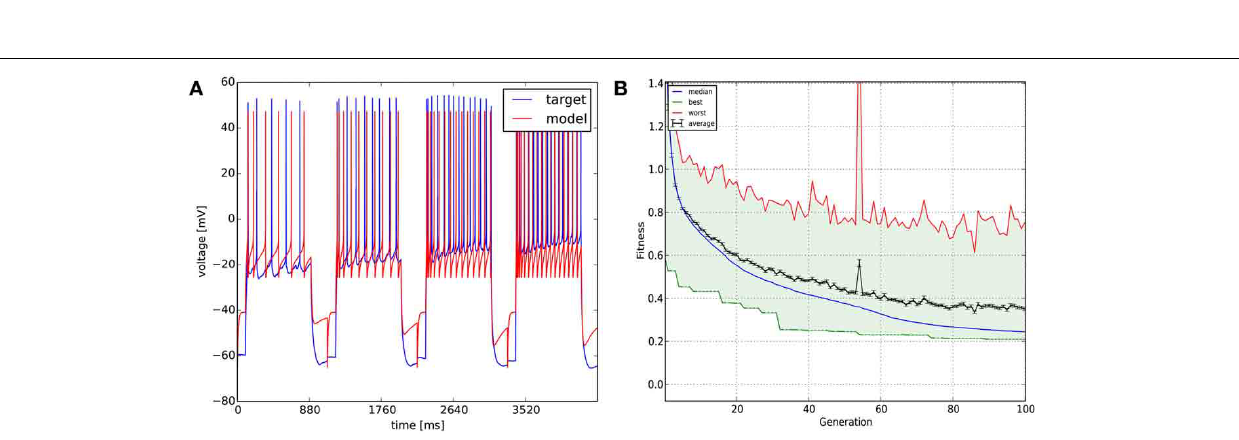
FIGURE 7 | The results of Optimizer on Use case 4 (fitting the parameters of a morphologically detailed passive multi-compartmental model to experimental data). Figure layout and notation are similar to Figures 4 , 5 . Magnified plots of critical parts of the traces are included in Figure 12 .